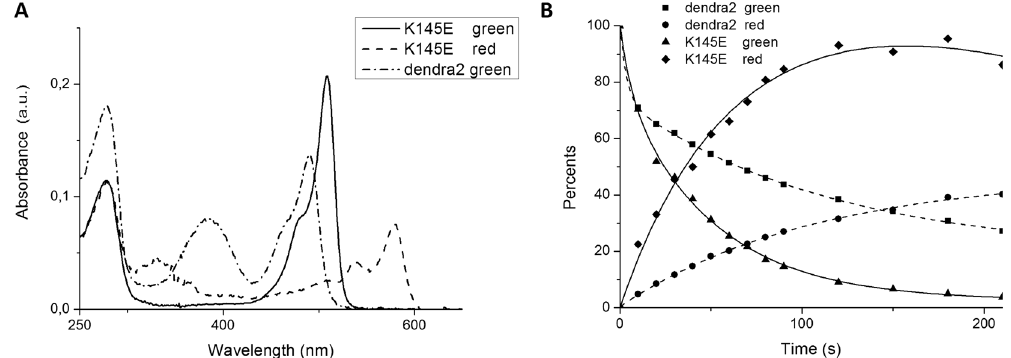
The photochemical reaction of conversion from green to red involves a non-reversible cleavage of the poly- peptide chain. Under constant light intensity at fixed wavelength 400 nm, this reaction can be formally described as a sequential monomolecular reactions (Fig. 8). According to Fig. 7, the red form of the protein is the most eas- ily observed, as it can be quantified by monitoring the fluorescence at 590 nm (in the case of SAASoti) or 580 nm (in the case of Dendra2). Since a change in pH alters the amount of the neutral photoconvertible form, green to red photoconversion constant k 1 and red form photobleaching constant k 2 represent only apparent rate constants. Thus, the maximal rate constants are the key parameters describing FP photoconversion (Fig. 9). For studied SAASoti mutants, the values of rate constants are in the range 0.6–0.9 s − 1 for k 1 and 0.07–0.11 s − 1 for k 2 (Table 4). For Dendra2, one finds k 1 = 0.03 s − 1 with no observable photobleaching. pK 1c and pK 2c that control photocon- version of green and red forms and calculated from the pH profile of k 1 and k 2 (Fig. 9) practically for all mutants are not coincide with pK 1 and pK 2 that control anion to neutral equilibrium of chromophore for both green and red forms (Table 4). Comparison of values obtained for SAASoti and Dendra2 indicate that the photoconversion of SAASoti pro- ceeds by more than an order of magnitude faster than for Dendra2. This allows for using much lower dose of 400 nm light for protein photoconversion, e.g. in cell models expressing SAASoti.